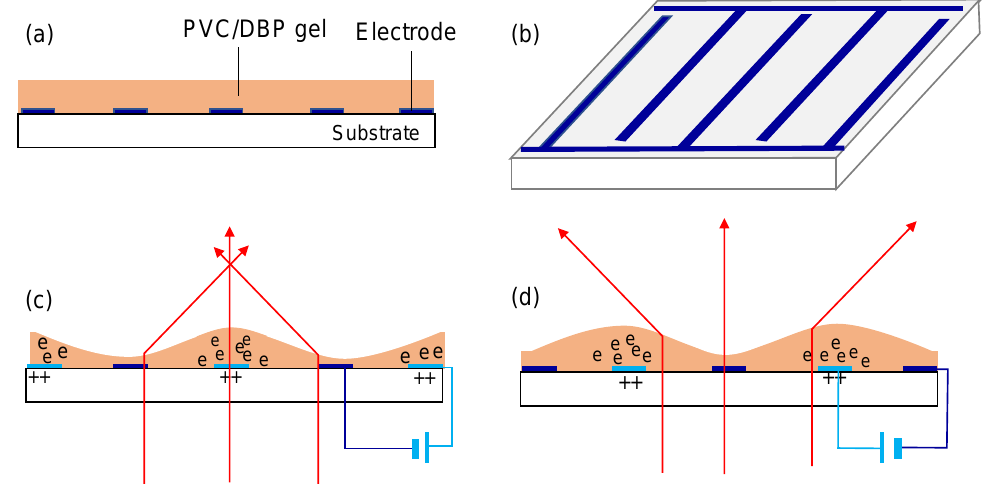
Figure 9. Device structure and driving method of the lenticular microlens array: ( a ) cross-sectional structure, ( b ) interdigitated electrode, ( c ) PVC membrane with undulated surface, and ( d ) shifting the surface profile using polarity inverted voltage.